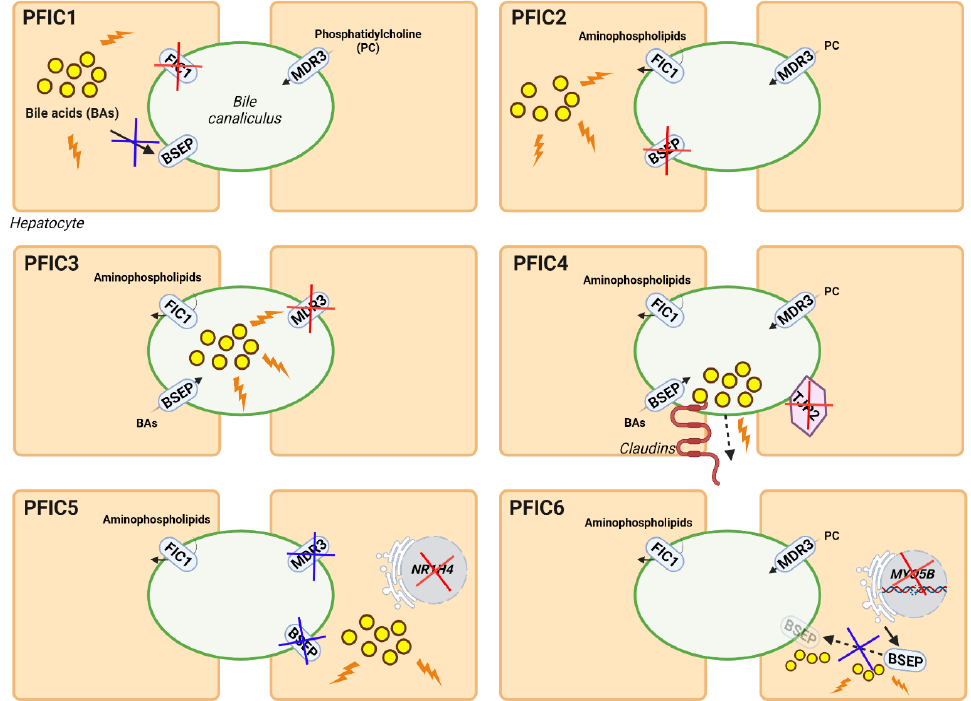
Figure 1. Genetic classification and pathogenesis of PFIC. The diagrams show the genes and functions altered in each type of PFIC. The main deficient proteins for each type of PFIC are indicated by red crosses, while derived alterations in other proteins or pathways are indicated by blue crosses. Damage due to the abnormal accumulation of BAs is shown as yellow circles with orange lightnings.